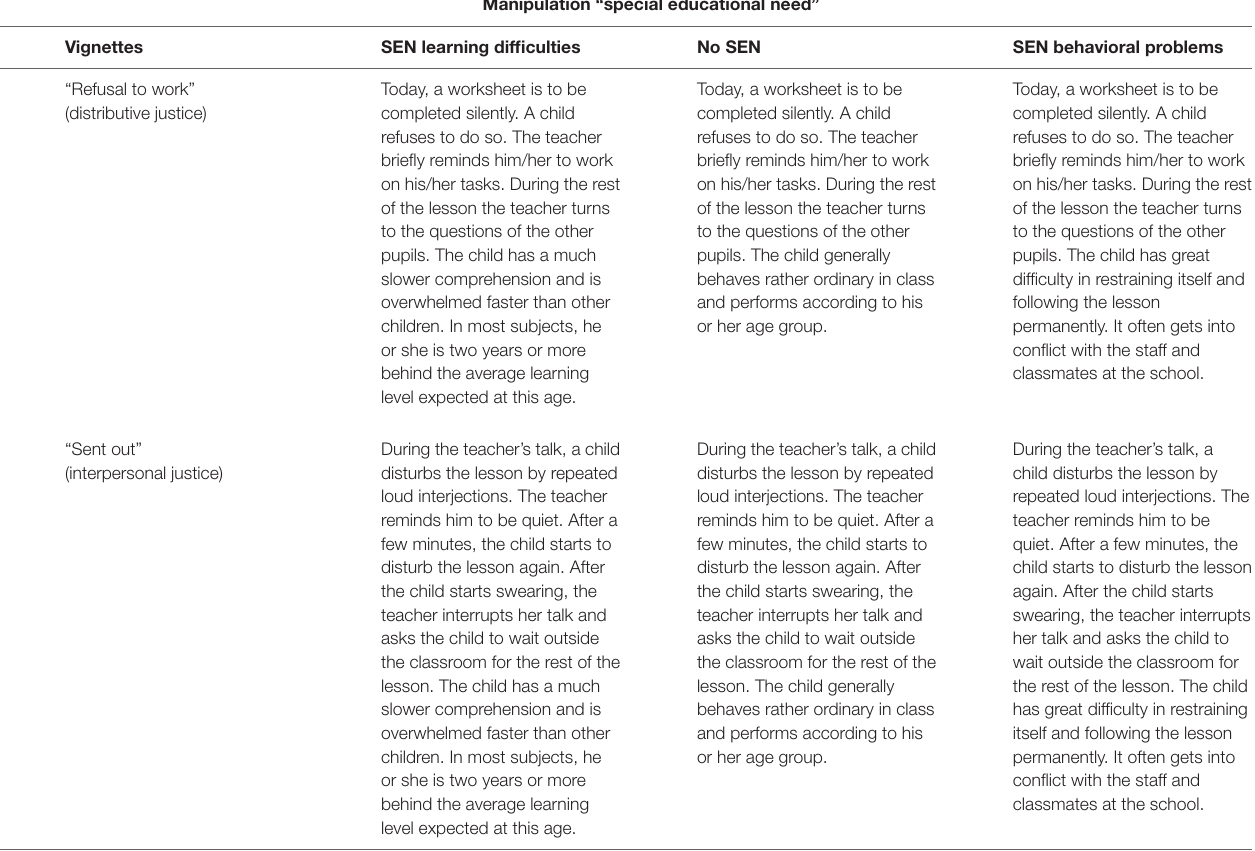
TABLE 1 | Wording of vignettes and their varying characteristic “special educational